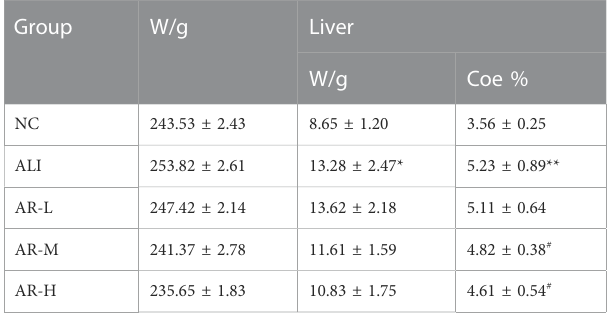
TABLE 1 The organ weight and organ coef fi cient of liver in each group (Mean ± s ).